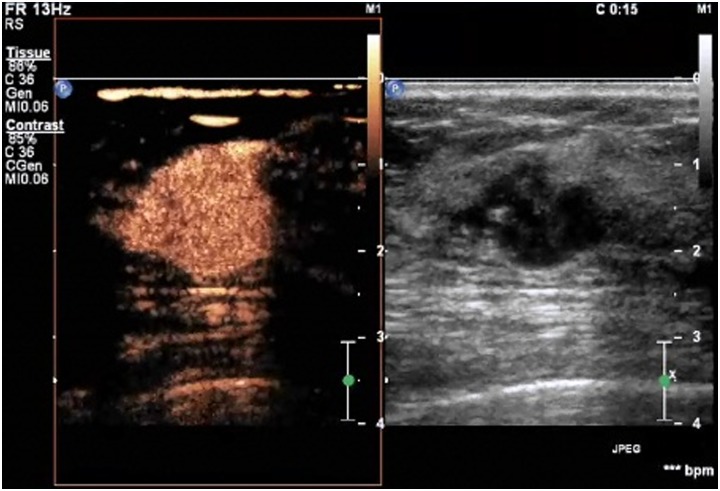
A lesion with a score of 4 by breast contrast-enhanced ultrasound.The lesion displays earlier enhancement than the surrounding tissue, usually heterogeneous. The scope of the lesion in the contrast-enhanced image is larger than in the corresponding 2D image, but the lesion still displays a clear margin, with/without a perfusion defect in the lesions and without crab claw-like enhancement.